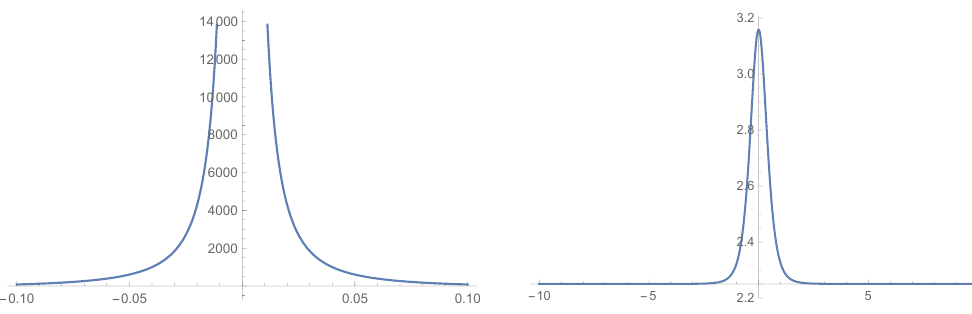
Figure 17 . The potentials for AdS (impenetrable) and for the meron